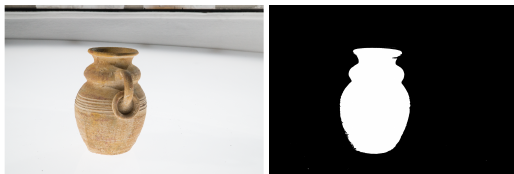
Figure 8: Example of image masking obtained through background subtraction.